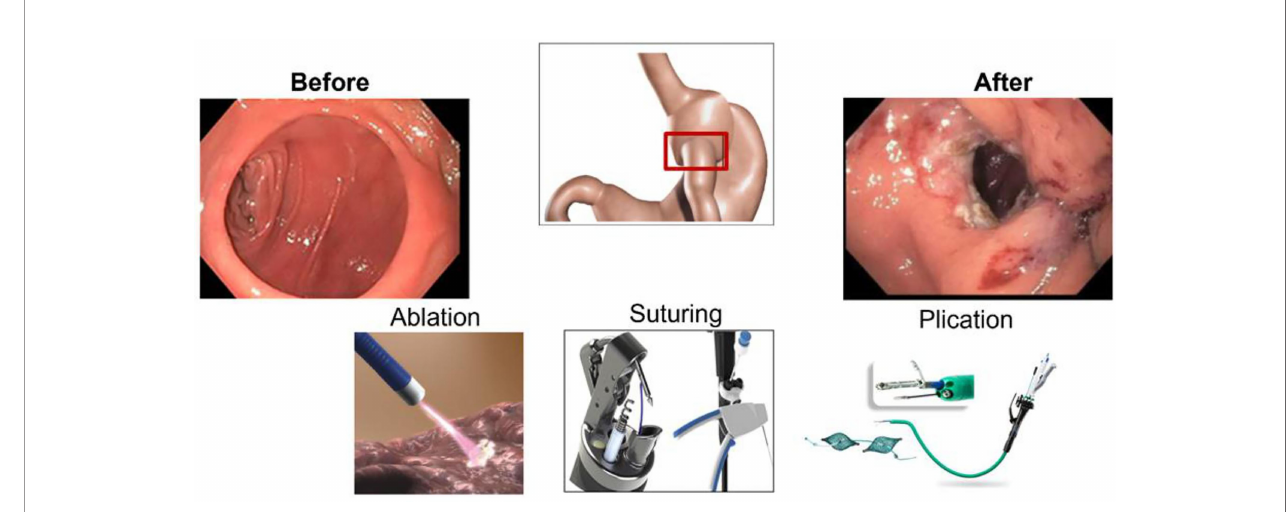
FIGURE 2 | Available modalities for endoscopic management of weight regain after